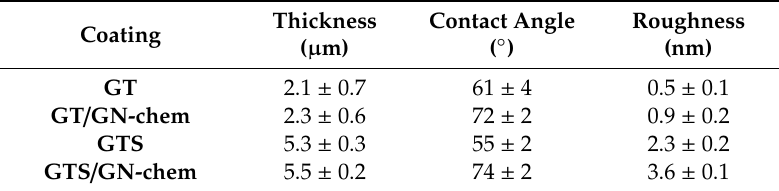
Table 2. Thickness, water contact angles and surface roughness of GT, GT / GN-chem, GPTMS-TEOS- colloidal silica (GTS) and GTS / GN-chem